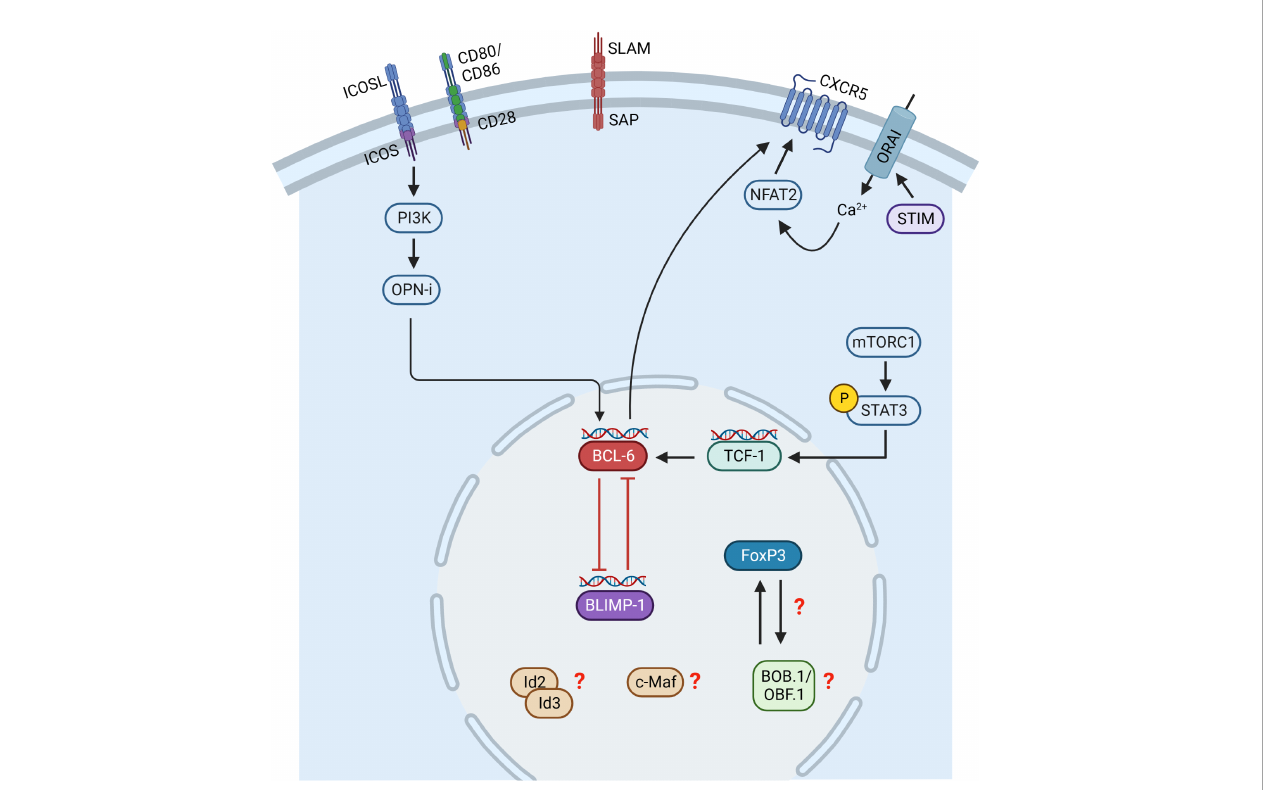
FIGURE 3 Transcriptional control of Tfr cell differentiation. Initial Tfr cell differentiation depends on CD28 and ICOS signaling, whereas interaction with B cells via SLAM/SAP is required for their full differentiation. Tfr cells express both BCL-6 and BLIMP-1 and possibly their balanced regulation is essential for Tfr cell differentiation. BCL-6 is regulated by ICOS and mTORC1. ICOS induces PI3K and its subunit p85 a interacts with osteopontin (OPN-i). OPN-i translocates to the nucleus preventing BCL-6 from ubiquitin-dependent proteasome degradation. mTORC1 induces phosphorylation of STAT3, activating TCF-1 expression, which upregulates BCL-6. Stromal interacting molecules (STIM) and ORAI proteins mediate Ca2+ entry inducing NFAT2, which upregulates CXCR5. Id2/Id3, c-Maf and BOB.1/OBF.1 are also involved in Tfr cell differentiation, but the exact mechanisms are incompletely understood so far. This fi gure was created with